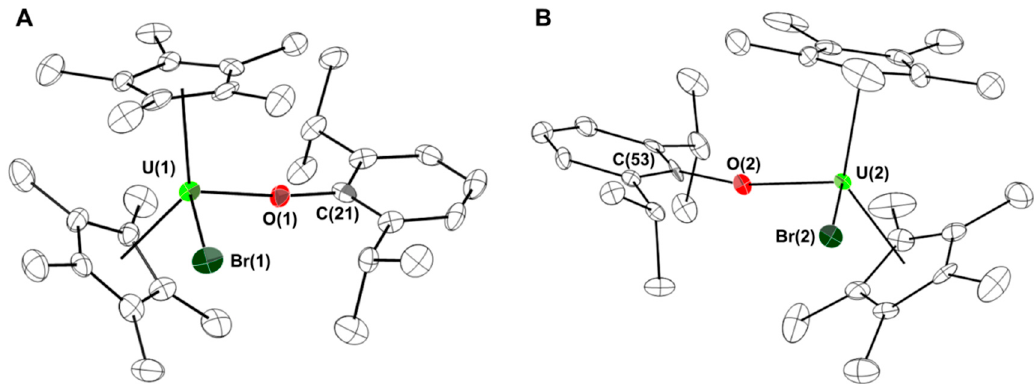
Figure 3. Molecular structures of the two crystallographically-independent (C 5 Me 5 ) 2 U( O -2,6- i Pr 2 C 6 H 3 )(Br) ( 37 ) complexes ( A and B ) with thermal ellipsoids projected at the 30% probability level. Hydrogen atoms have been omitted for clarity. Selected bond distances (Å) and angles (°): U(1)–O(1),